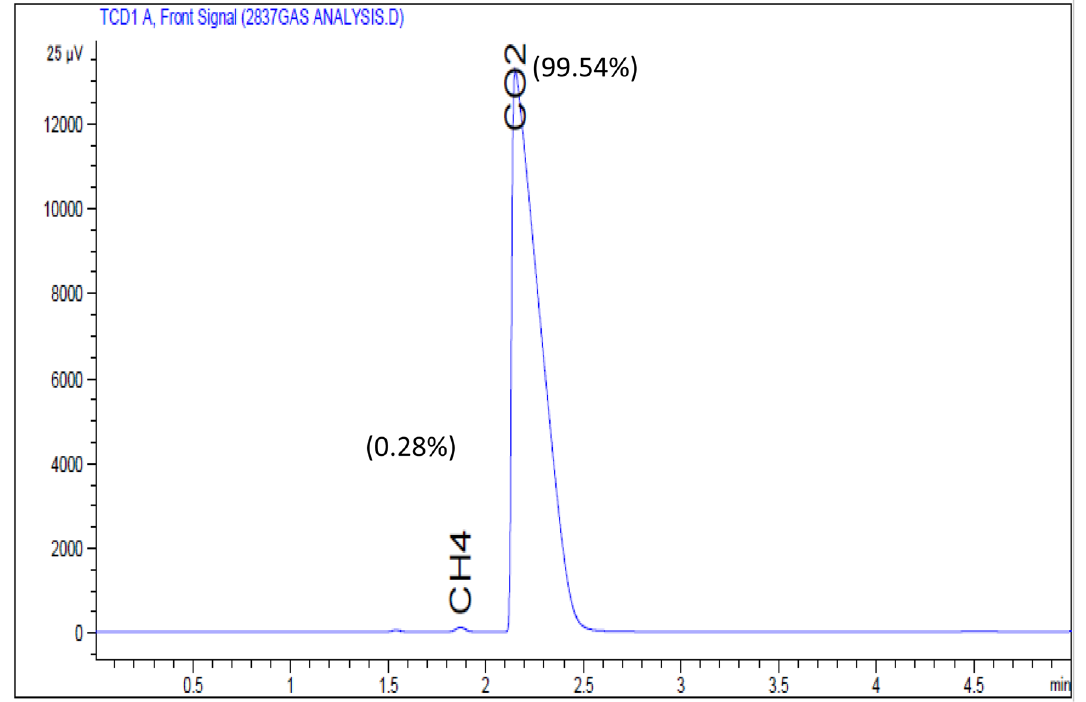
Fig. 13 CO 2 and CH 4 composition recorded by the GC at the termination stage of the core flooding